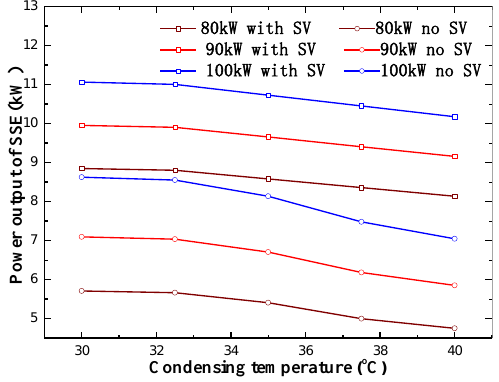
Figure 15. Power output of SSE vs. condensing temperature.